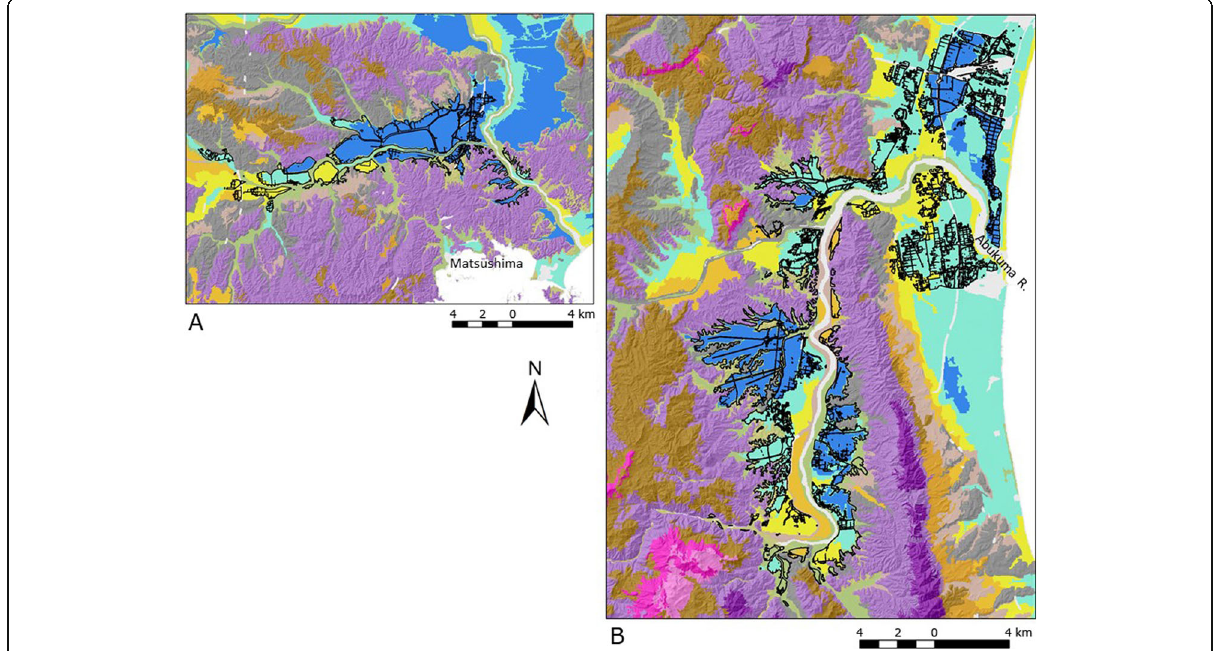
Fig. 17 Image overlays of the area of floods caused by the 2019 Typhoon Hagibis. Legend of the current classification is the same as in Fig. 14. Location maps are included in Fig. 14. The areas of flood (black lines) were estimated by GSI (2019 Oct 18). a Around Yoshida River, Miyagi Prefecture. b Around Abukuma River, Miyagi